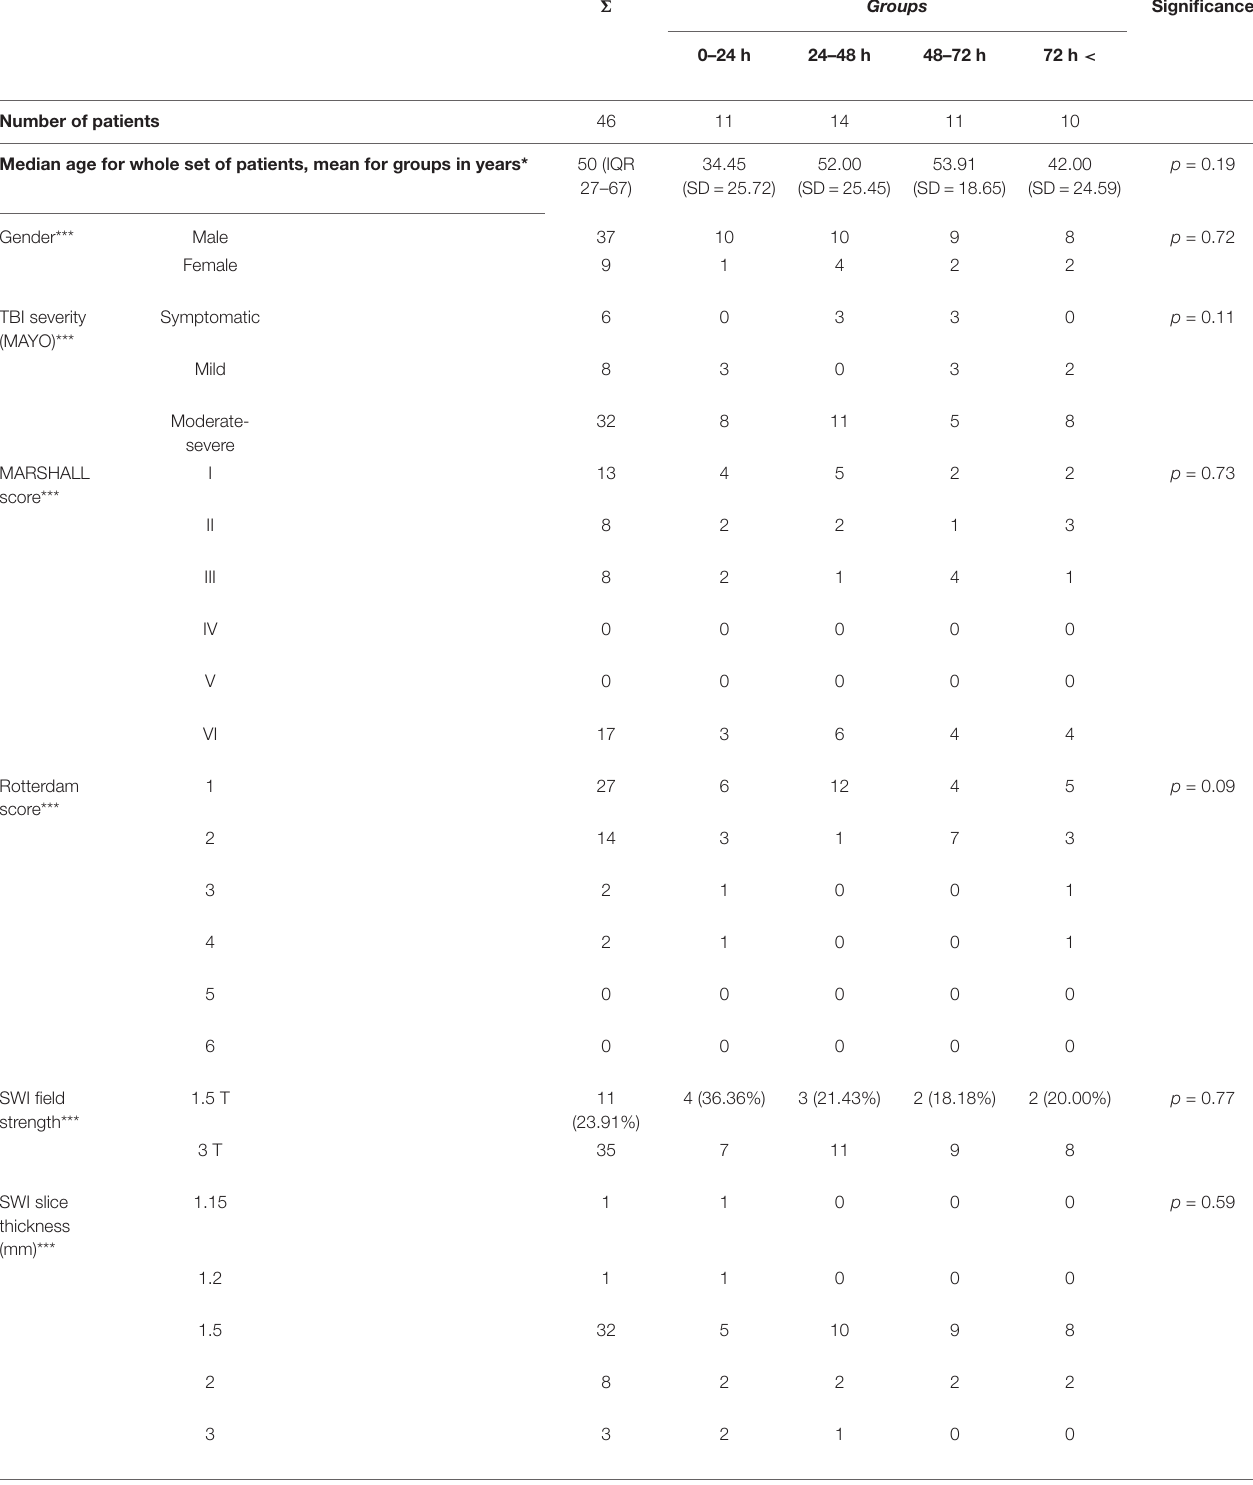
TABLE 2 | Influential factors of TMB count: age, TBI severity, and relevant SWI imaging data, level of significance of differences between groups.